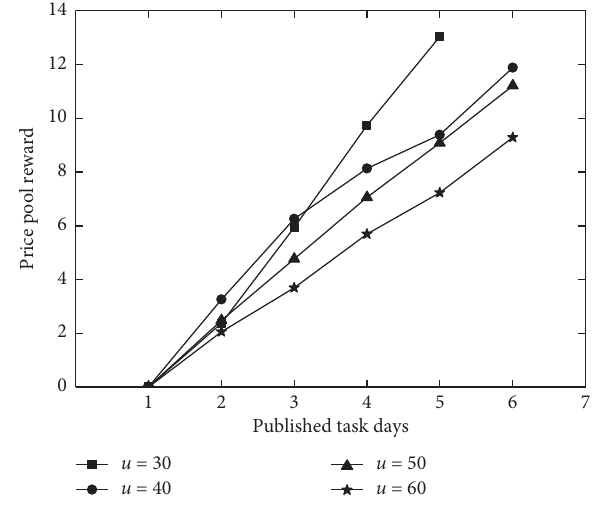
Figure 4: Price pool